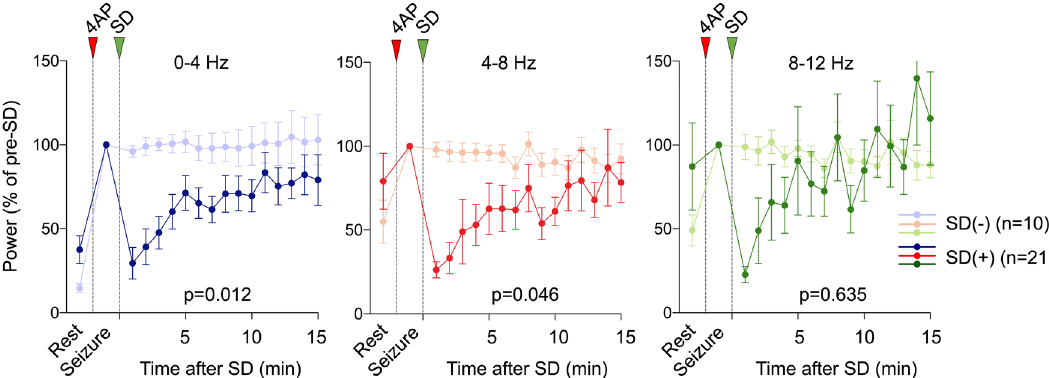
Fig. 8 Spontaneously occurring SD terminates focal cortical seizures and limits their reemergence. Average ECoG power time course in δ (0 – 4 Hz), θ (4 – 8 Hz), and α (8 – 12 Hz) frequency bands show ECoG power at rest, during the seizure (5 min prior to SD, and every minute thereafter, expressed as % of pre-SD seizure power. Spontaneously arising SD signi fi cantly diminished seizure intensity (bold curves) compared with controls without an SD (faint curves) in δ (0 – 4 Hz) and θ (4 – 8 Hz) bands (two-way ANOVA for repeated measures; ±SEM). Sample sizes are shown on the graph. Only the fi rst SD in each experiment is